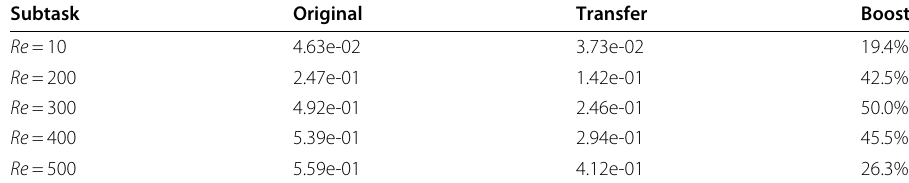
Table 6 Performance boost of GP-PINN on the Navier-Stokes equations using transfer learning Subtask Original Transfer Boost Re =10 4.63e-02 3.73e-02